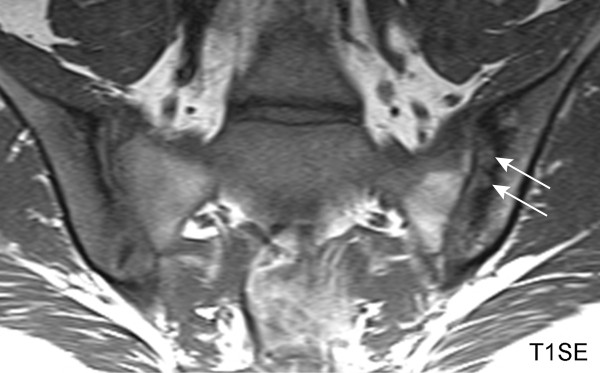
Classical erosion (T1SE sequence). HLA B27 positive, 18-year-old female AS patient with inflammatory back pain for two years. Erosion in the left ilium (arrows) is characterized by loss of visualization of the cortical bone. The erosions are well visualized because they are surrounded by sclerosis as evidenced by very dark signal in the adjacent bone marrow. HLA-B27, human leucocyte antigen B27; T1SE, T1-weighted spin echo sequence.